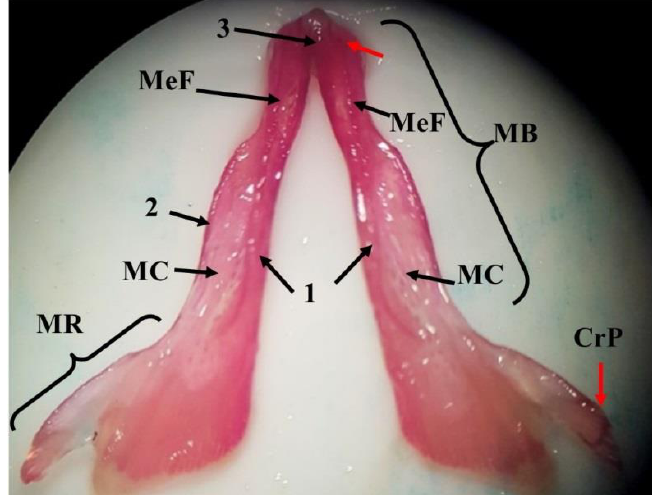
Figure 3. A stereomicrograph of a dorsomedial view of the mandible in a 45 th -day old Yankasa fetus, showing mandibular body (MB), mandibular rami (MR), mental foramen (MeF), mandibular canal (MC), ossification centres (red arrows), and ossifying medial (1) and lateral (2) parts of MB, mandibular symphysis (3), and coronoid process (CrP), Alizarin stain